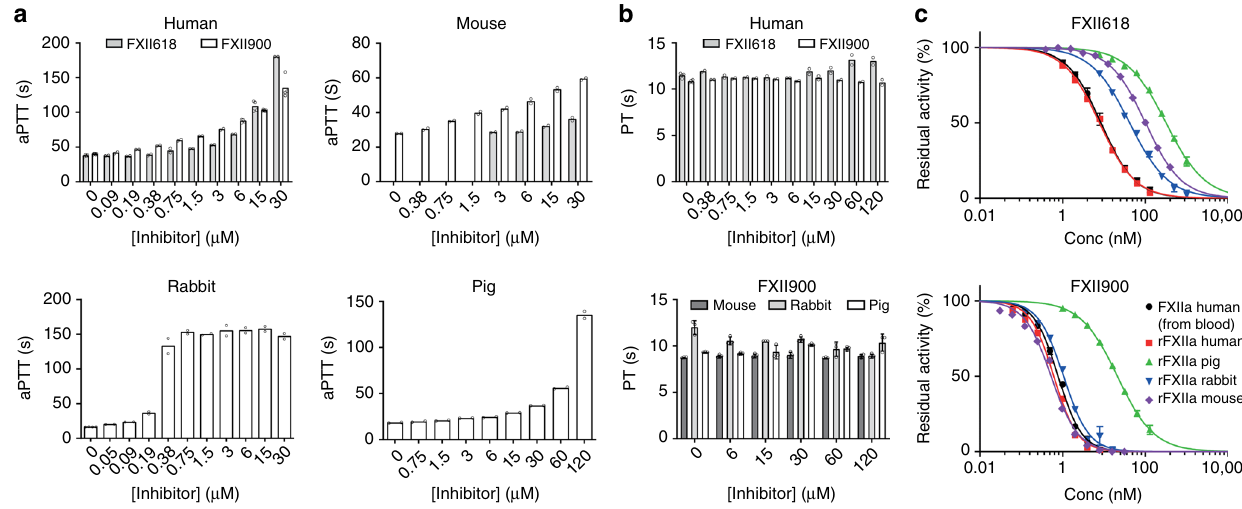
Fig. 2 Inhibiting FXIIa of different species. a Inhibition of the intrinsic coagulation pathway in human, mouse, rabbit, and pig plasma ex vivo. The aPTT in the presence of different concentrations of FXII900 is shown. For human and mouse plasma, the aPTT of FXII618 was measured for comparison. All coagulation times were determined in two, four or six independent measurements. Mean values are indicated. Data of individual measurements are shown as dots. b PT in the presence of different concentrations of FXII900 and FXII618 in human plasma (upper panel), and FXII900 in mouse, rabbit, and pig plasma (lower panel). PT was determined in two (human plasma) or three independent measurements (all animal plasmas). Mean values are indicated. Data of individual measurements are shown as dots. For the animal plasmas, means ± SD is indicated. c Inhibition of recombinant FXIIa (rFXIIa) from different species by FXII618 and FXII900. The inhibition of human FXIIa derived from blood is shown for comparison (data from Fig. 1c). Residual FXIIa activities were determined in two (human, mouse) or three (pig, rabbit) independent measurements. Mean values are indicated. For pig and rabbit FXIIa inhibition, the data are presented as mean ± SD. Source data of a – c are provided as a Source data fi le.